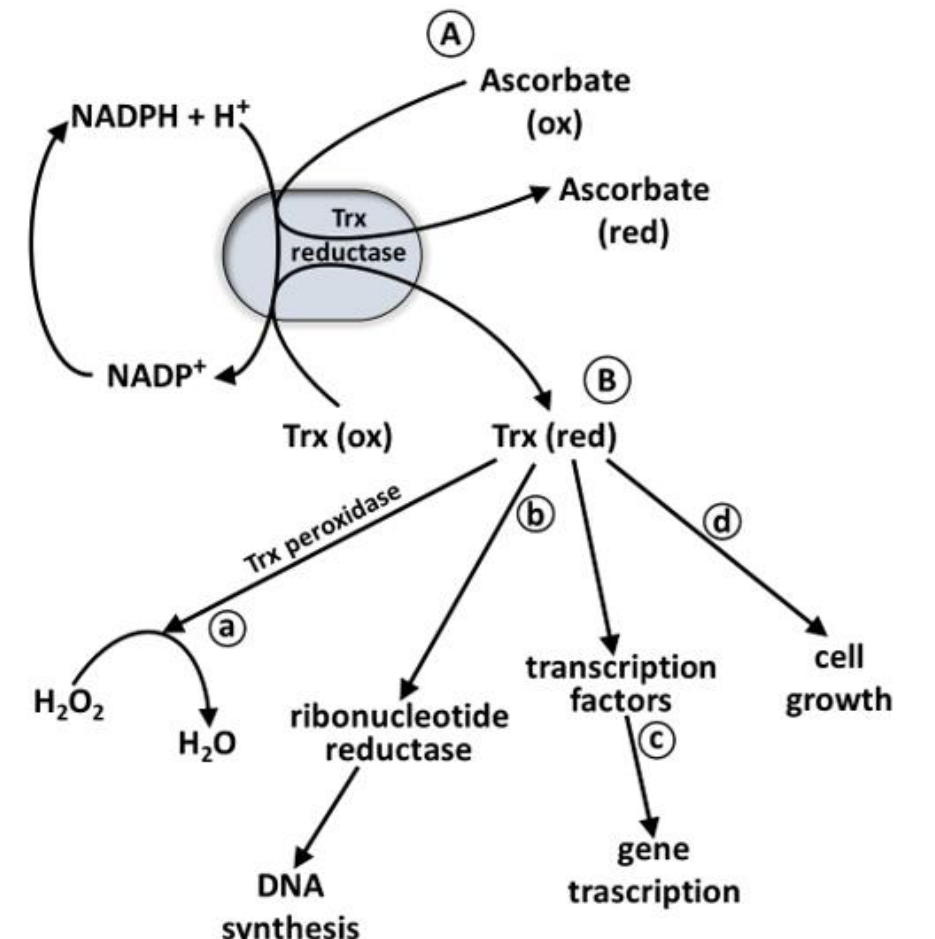
Figure 3. Reactions and functions of TrxR. ( A ) NADPH + H + catalyzed in the presence of TrxR the reaction of Trx (Ox) into Trx(Red) to reduce ascorbate (Ox) into ascorbate (Red). ( B ) Reduced Trx supplies reducing equivalents to break down H 2 O 2 to H 2 O in the presence of Trx peroxidase ( a ); reduced Trx in the presence of ribonucleotides reductase reduces ribonucleotides to deoxiribonucleotides for DNA synthesis ( b ); Trx (Red) provides reducing equivalent for transcription factors resulting in their increased binding to DNA leading to altered gene transcription ( c ); reduced Trx increase cell growth ( d ). Abbreviations: NADP + : Nicotinamide Adenine Dinucleotide Phosphate; NADPH: Nicotinamide Adenine Dinucleotide Phosphate (reduced form); Trx: thioredoxin; Trx (Ox): thioredoxin oxidized; Trx (Red): thioredoxin reduced; TrxR: thioredoxin reductase.